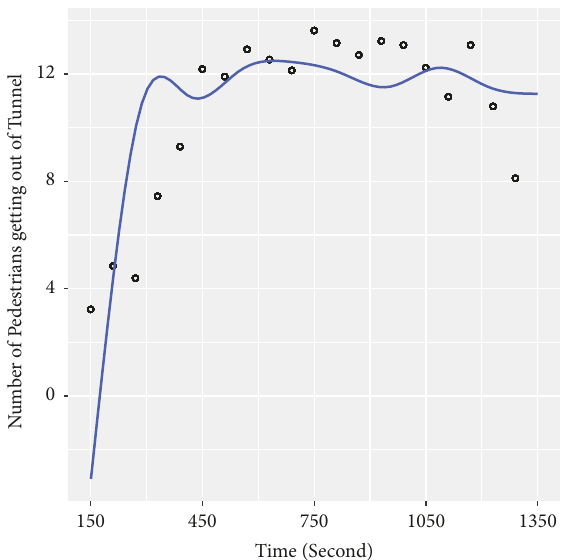
Figure 8: Number of pedestrians getting out of tunnel varies over time (circles show data collected from tunnel and the blue curve shows data collected from